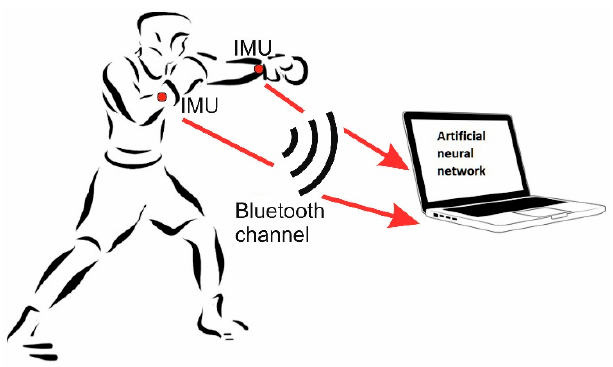
Figure 1. Design of the experiment. The boxers wore standard sportswear and 10-ounce boxing gloves.